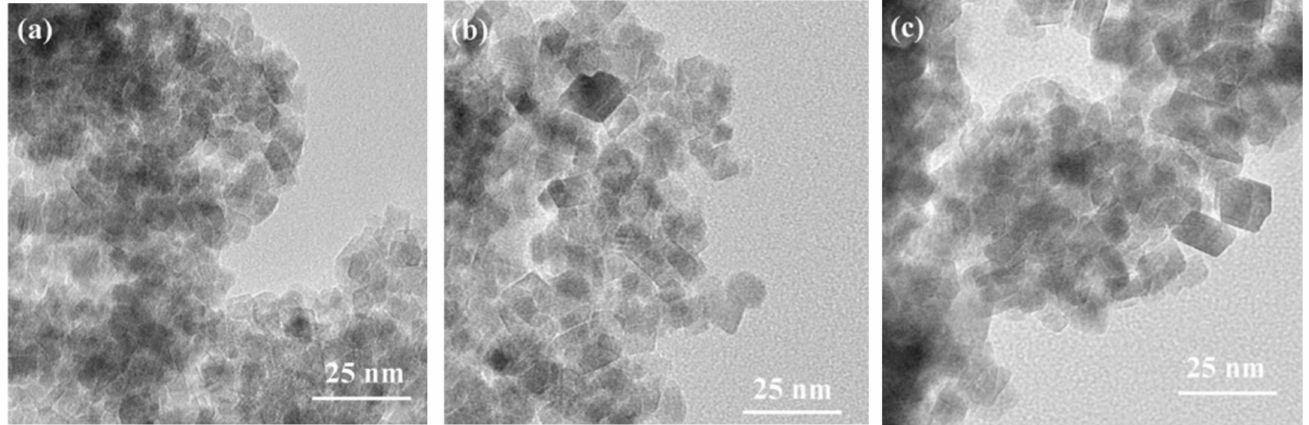
Figure 4. The transmission electron microscope images of the ZnFe 2 O 4 nanoparticles prepared at different hydrothermal temperatures: ( a ) 160; ( b ) 180; and ( c ) 200 ◦ C [57] (reprinted with permission from [57] Zhu et al.,